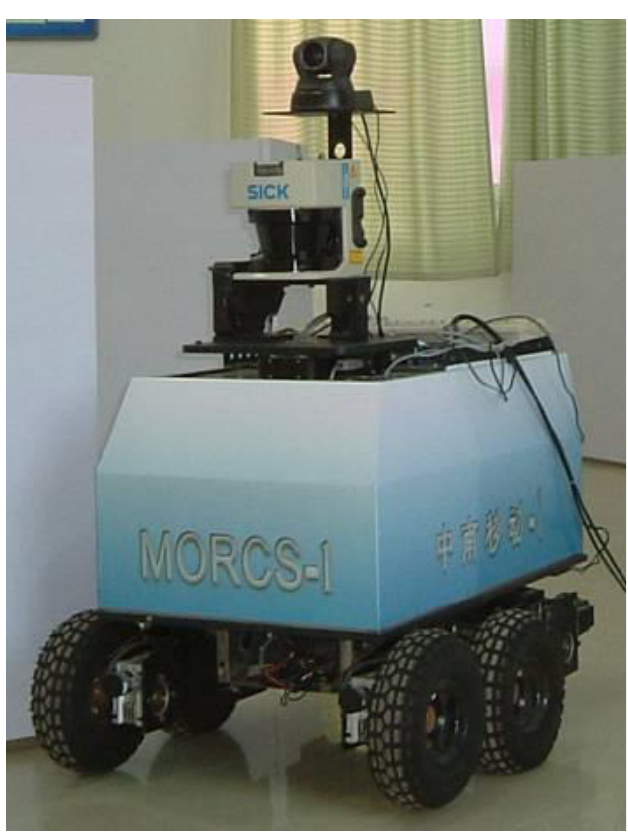
Figure 1. The robot MORCS-1.